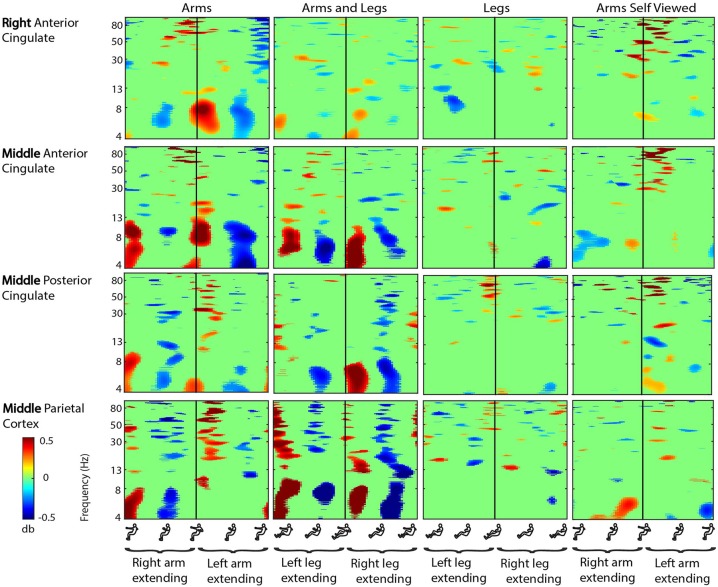
Cingulate cortex ERSPs. Event-related spectral perturbation (ERSP) plots showing change in spectral power during rhythmic upper and lower limb movement in the right anterior cingulate, the middle anterior cingulate, the middle posterior cingulate, and the middle parietal cortex. From left to right, subjects moved with their arms only, both their arms and legs, their legs only, and viewed video playback of themselves moving with just their arms. Each row represents a cortical area, and each column represents a condition. For all plots, red represents a power increase from baseline, and blue represents a power decrease from baseline. We set non-significant differences to 0 dB (green). All ERSPs start and end with the same limb fully extended. The figure outlines on the x axis indicate the phase of movement, and the written labels indicate when each limb was extending. Note: for the arms and legs condition, the left leg and right arm extended together, and vice versa.